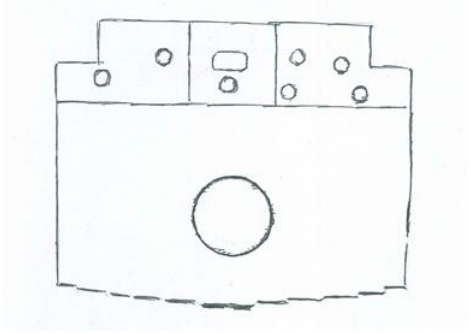
Figure 2. Line drawing of the cross-section of the keel joint of the Quanzhou Bay shipwreck. Line drawings based on (Fujiansheng quanzhou haiwai jiaotongshi bowuguan 福 建 省 泉 州 海 外 交 通 史博 物 館 1987, p. 16). Courtesy of Mr. Eason Y.